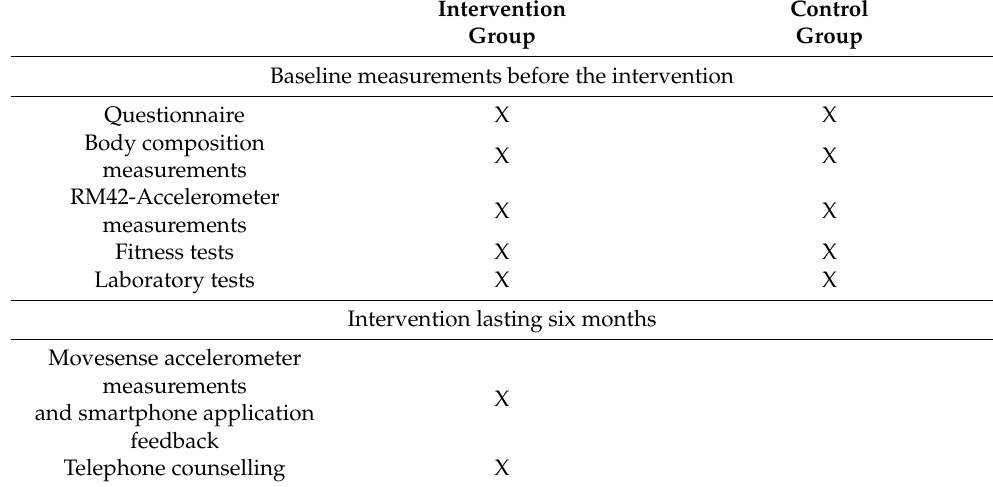
Table 1. Intervention procedure and measurements of the